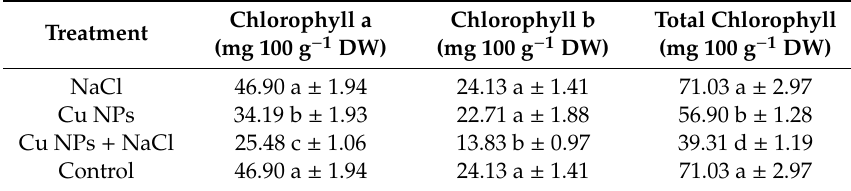
Table 2. Chlorophyll content in leaves of tomato plants under saline stress and foliar application of Cu